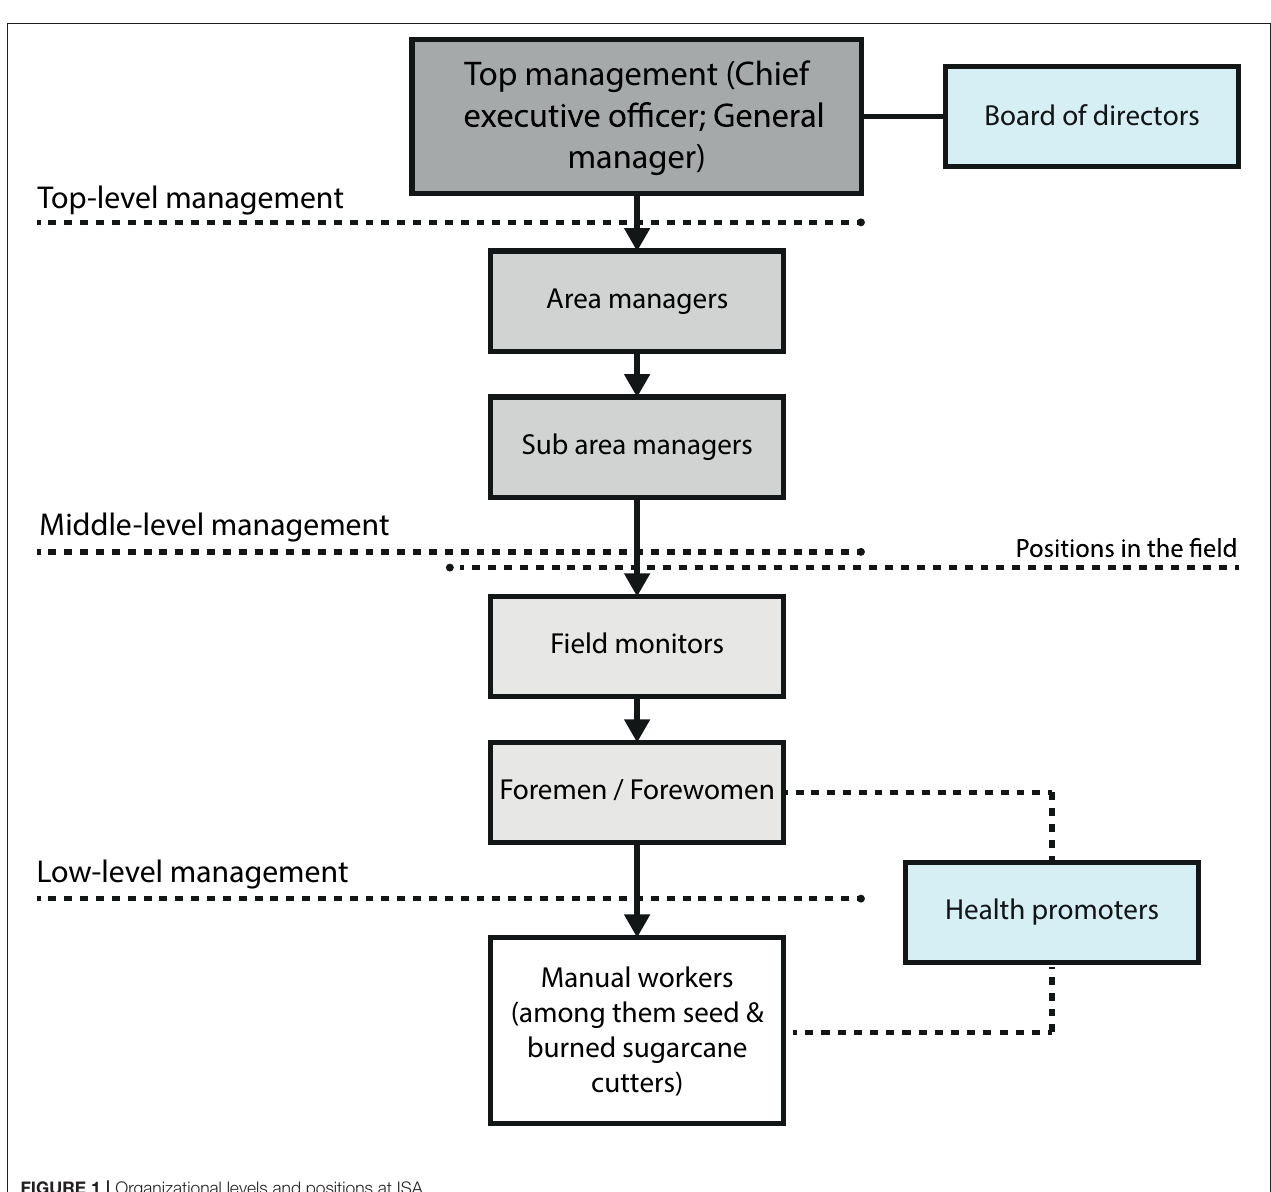
FIGURE 1 | Organizational levels and positions at ISA.